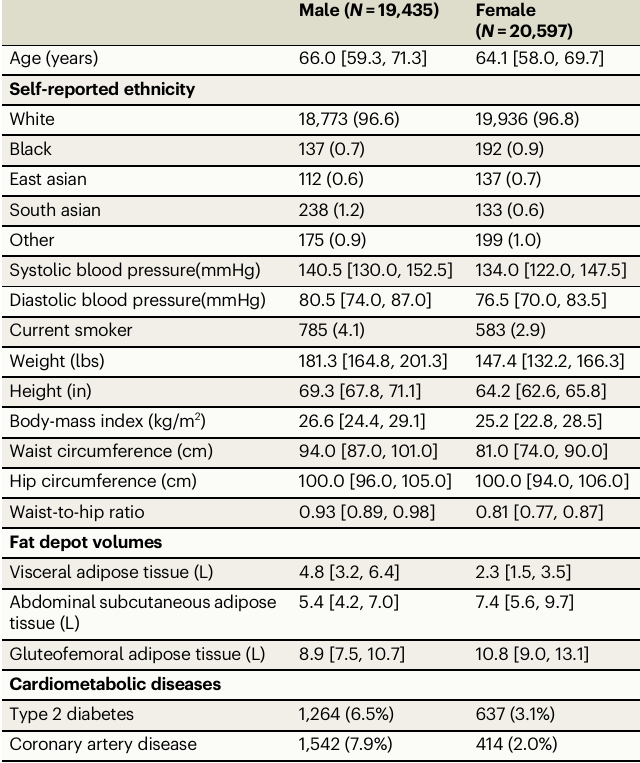
Table 1 | Baseline characteristics of UK Biobank participants at the time of MRI